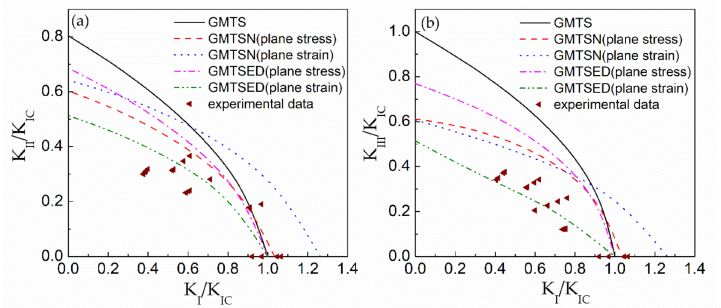
Figure 17. Mixed fracture toughness–predicted values of the fracture criterion and the testing data for sandstone. ( a ) The mixed mode I/II fracture toughness–predicted values. ( b ) The mixed mode I/III fracture toughness–predicted values.